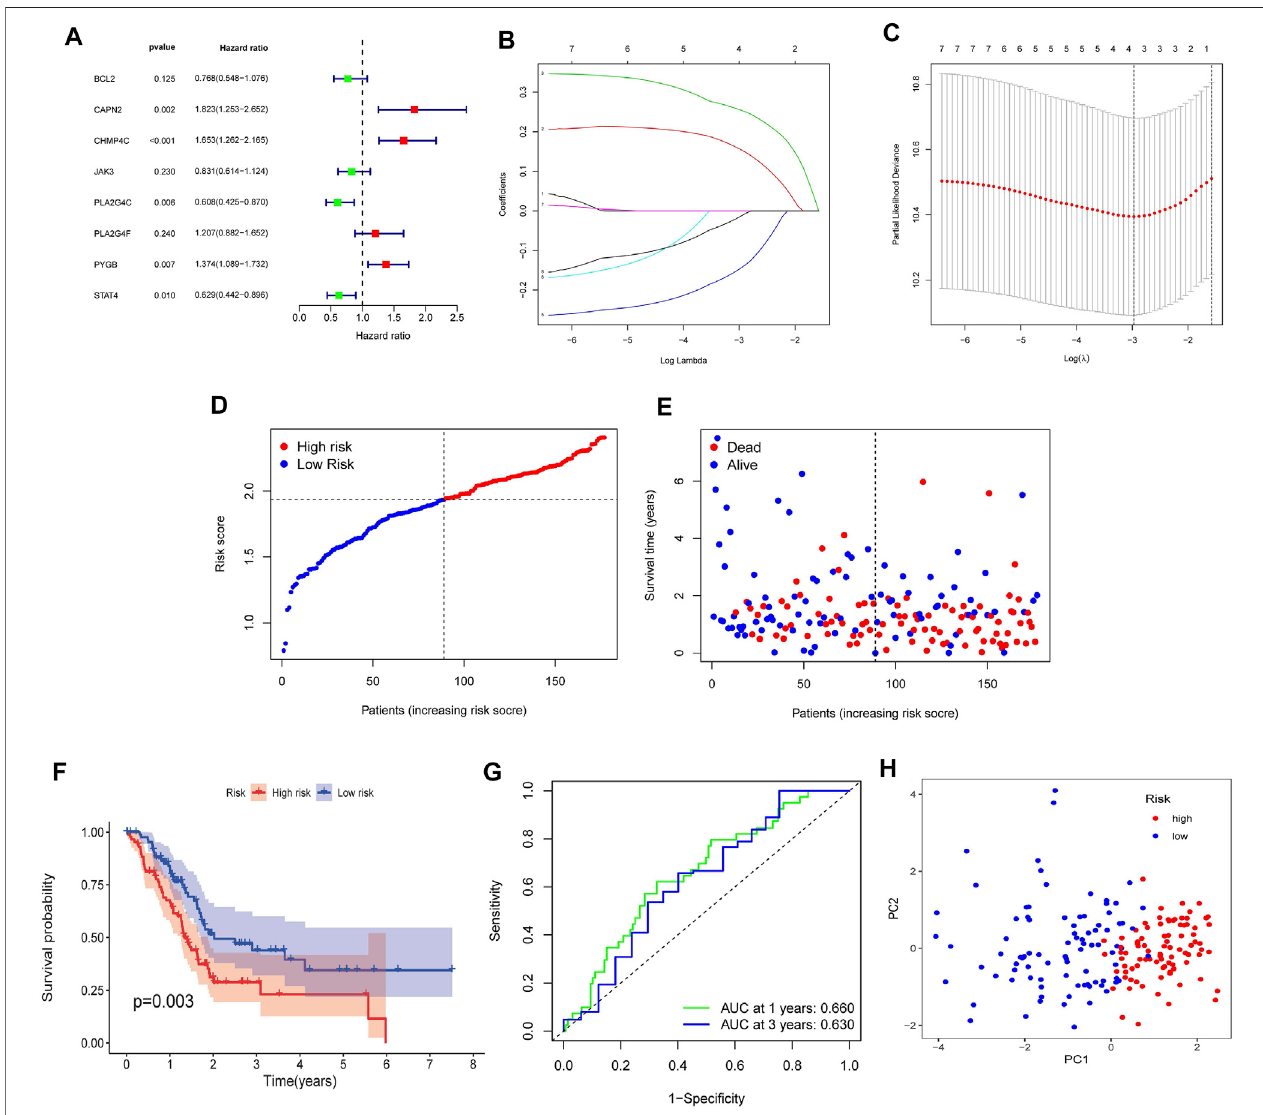
FIGURE 5 | Construction ofthe NRGs-based prognosticrisk model in the TCGACohort. (A) UnivariateCoxregression analysis for 10NRGs. (B) LASSO Cox regression analysisof8NRGs. (C) Crossvalidationmethodtoselectoptimalgenes. (D) Distributionofriskscore. (E) Thesurvivalstatusandsurvivaltimedistribution. (F) Kaplan-Meiersurvival analysis between the high-risk group and the low-risk group. (G) Time-dependent ROC curve to evaluate the ef fi ciency of the model. (H) Results of PCA analysis.